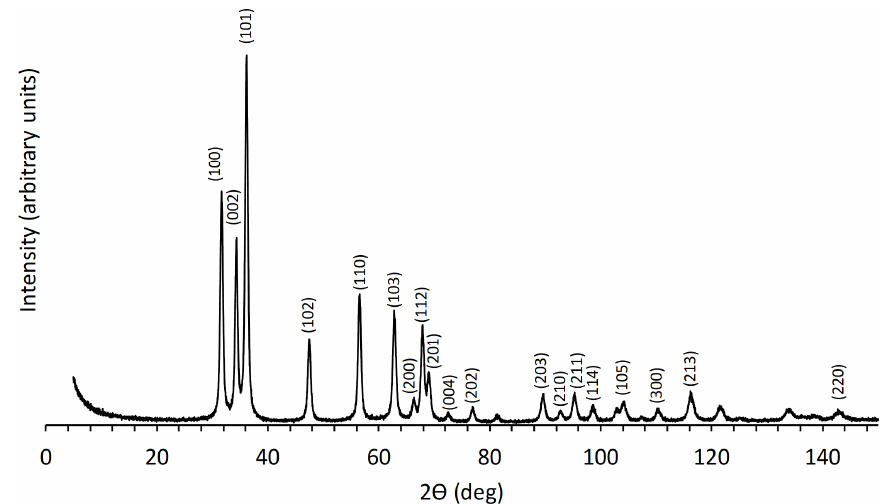
Figure 3. Measured diffractograms of samples ZnO, ZnO-PyQAs1-1%, ZnO-PyQAs1-2.5%, and ZnO-PyQAs1-5% (overlapping).